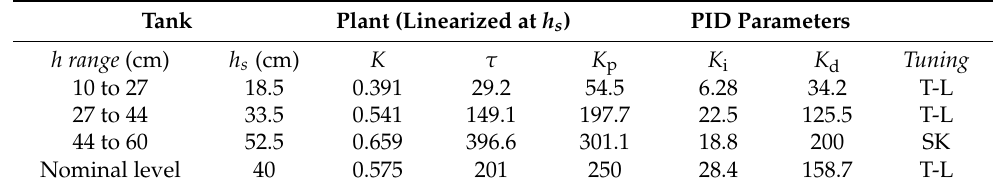
Table 3. Level segment parameters for GSPID control and nominal level for PID control. Tank Plant (Linearized at 𝒉 𝒔 ) PID Parameters